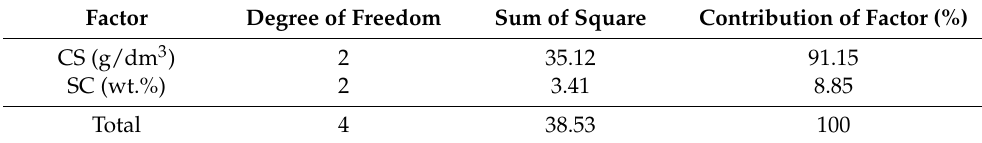
Table 7. ANOVA for S/N ratios (for